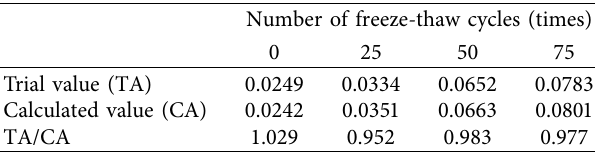
Table 7: Comparison between the trial value and calculated